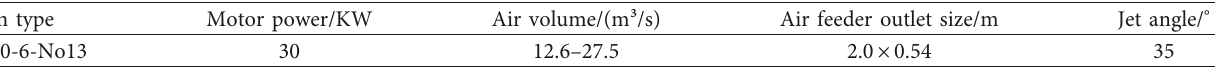
Table 4: No.7 type air curtain fan in Longshou mine and its main technical parameters.